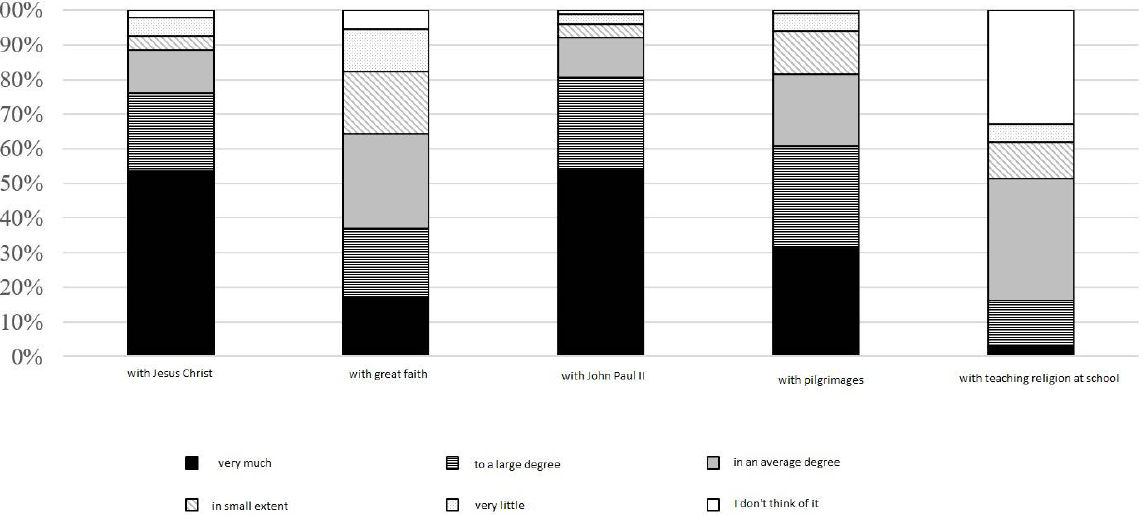
Figure 4. Association of the Catholic Church in Poland with main Christian values. Source: authors’ own elaboration.